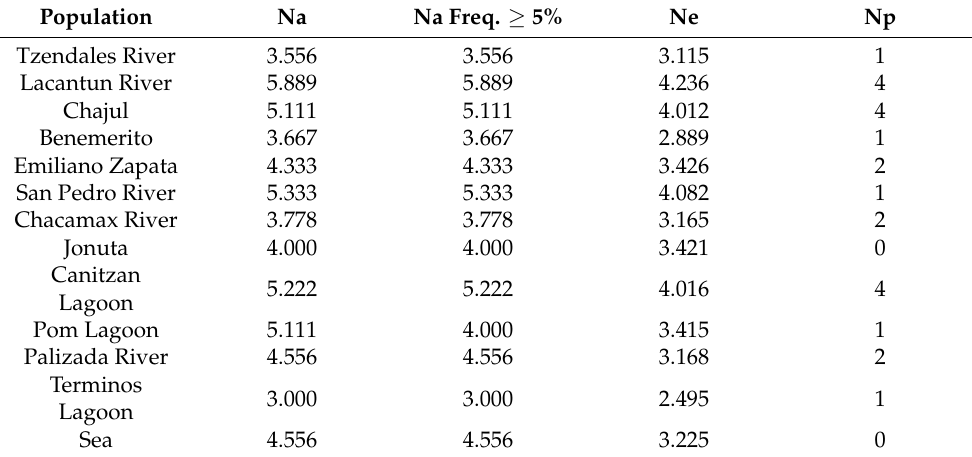
Table 3. Descriptive statistics for the microsatellite data in the Usumacinta River basin. Na = number of different alleles; Na (Freq ≥ 5%) = number of different alleles with a frequency ≥ 5%; Ne = number of effective alleles; Np = number of private alleles or the number of alleles unique to a single population. Population Na Na Freq. ≥ 5% Ne